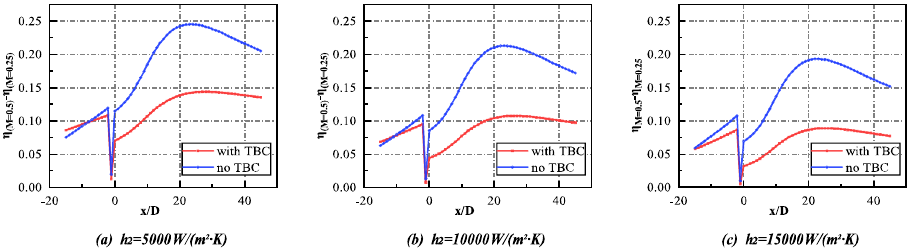
Figure 8. Distribution of ( η M = 0.5 − η M = 0.25 ) at γ = 9 under different h 2 . Figure 8. Distribution of (cid:4666)𝜂 (cid:3014)(cid:2880)(cid:2868) . (cid:2873) (cid:3398) 𝜂 (cid:3014)(cid:2880)(cid:2868) . (cid:2870)(cid:2873) (cid:4667) at γ (cid:3404) 9 under different h 2 . Figure 8. Distribution of (cid:4666)𝜂 (cid:3014)(cid:2880)(cid:2868) . (cid:2873) (cid:3398) 𝜂 (cid:3014)(cid:2880)(cid:2868) . (cid:2870)(cid:2873) (cid:4667) at γ (cid:3404) 9 under different h 2 .